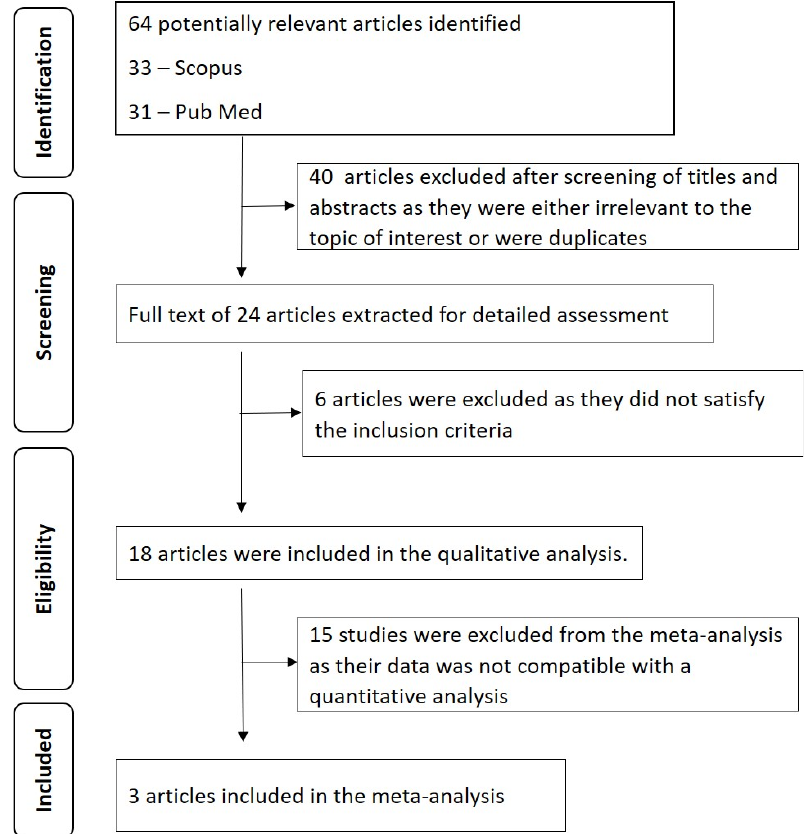
Figure 1. Prisma flowchart summarizing the workflow of the systematic review.